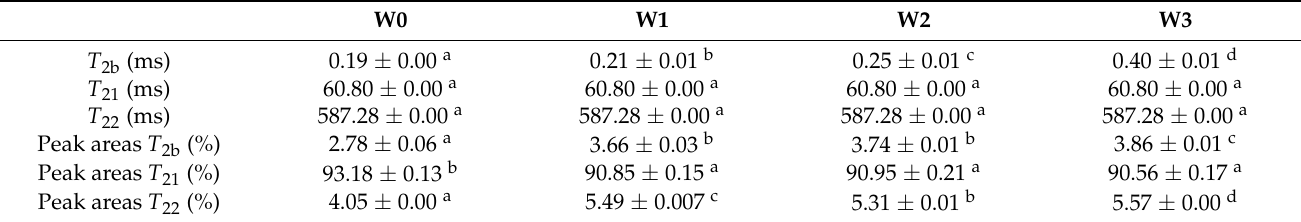
Figure 2. T 2 relaxation times of surimi gel with different washing times. Table 5. Changes of T2 relaxation times of surimi gel with different washing times.